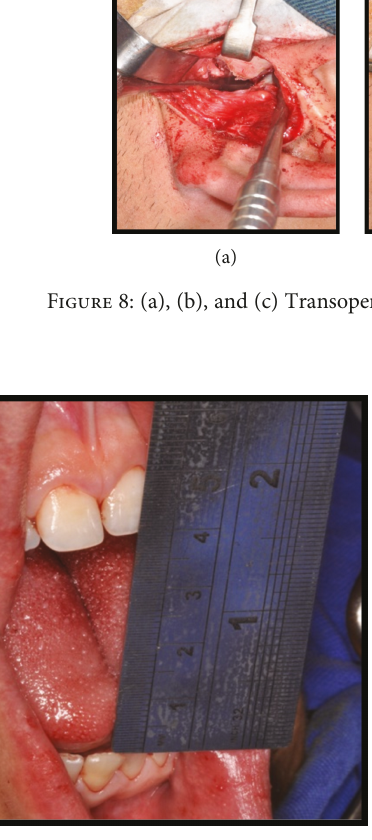
Figure 9: Mouth opening of 39mm in the